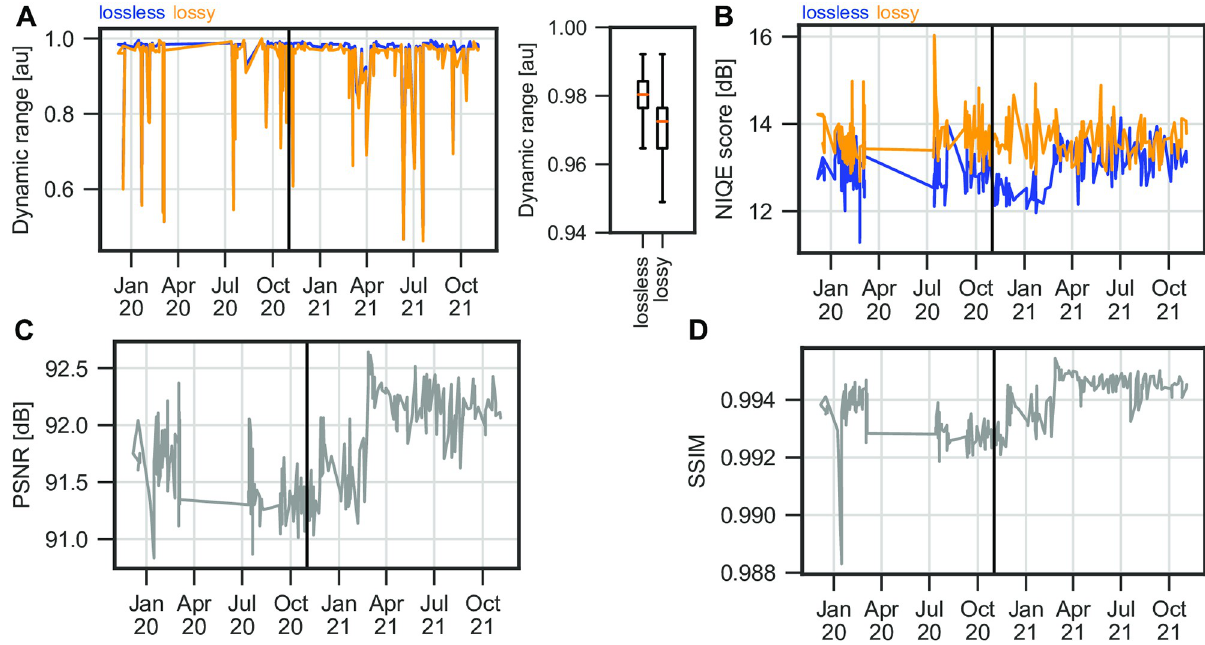
Fig 3. Image quality is relatively stable across time. A: Dynamic range per recording. Lossless compressed data in blue, lossy in orange. Boxplots show the 95-percentile of the data. B: NIQE score for lossy (orange) and lossless (blue) compressed videos across time. C: Peak-Signal-To-Noise-Ratio (PSNR) across time. D: Structural Similarity Index Measure (SSIM) across